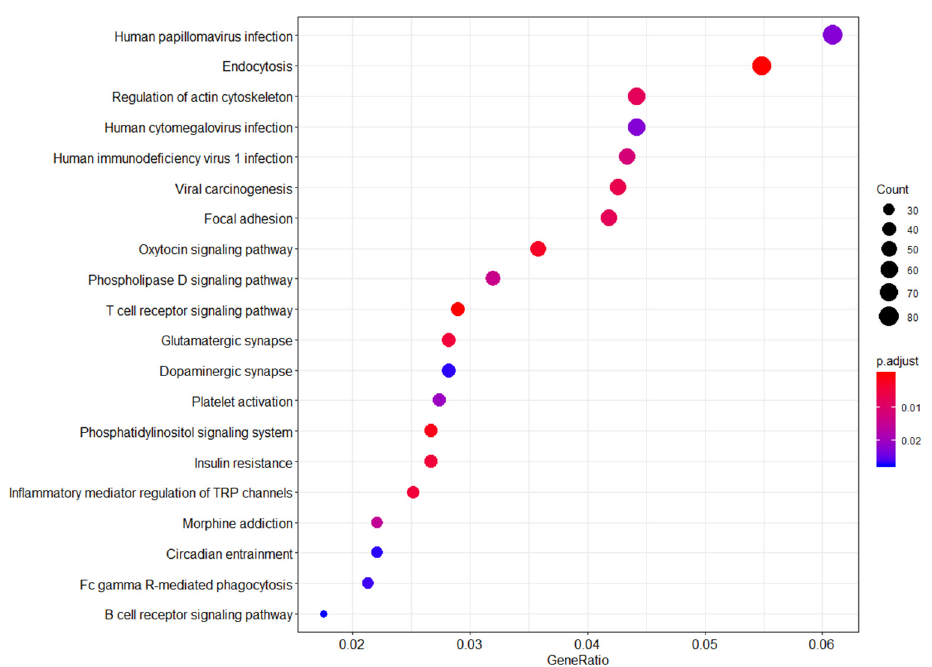
Figure 1. Functional genomic pathways enriched in the WTC-exposed (WTC EHC) breast cancer cases vs. unexposed (NYUWHS) breast cancer cases. Legend: Summary of pathway network analysis highlights the relationship between probe sets enriched in the WTC-exposed women compared to unexposed women. Y-axis shows the probe sets with significant overlap with the reference probe sets/genes from the KEGG database. X-axis shows the ratio of the number of differentially expressed probe sets/genes to the total number of genes included in the particular pathway gene set from the reference KEGG pathway database. The dot sizes are proportional to the number of overlapping probe sets/genes. The dot colors show the p ‐ value adjusted for false discovery rate.